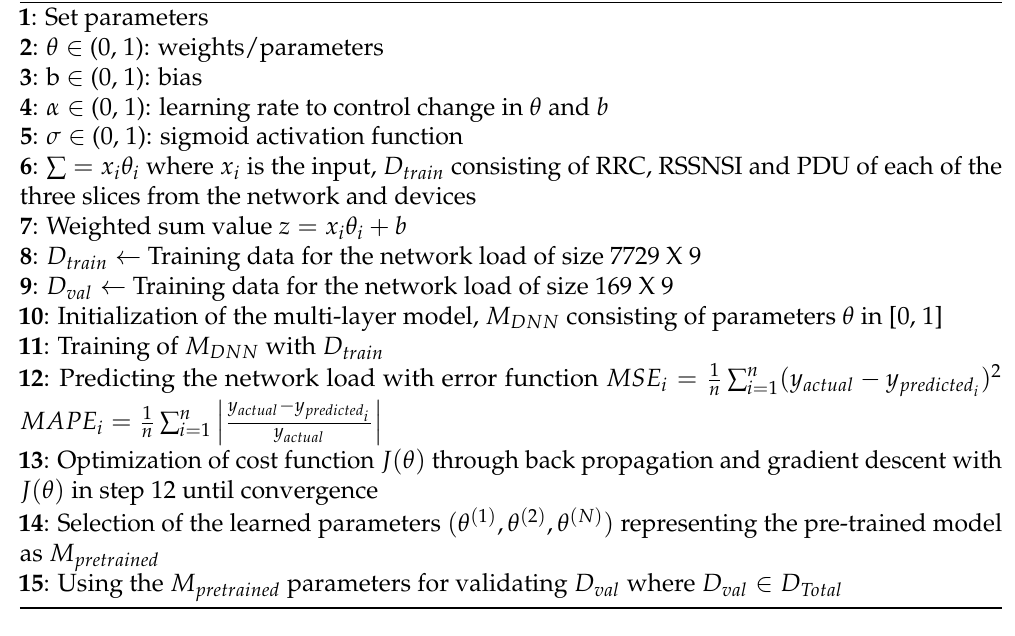
Algorithm 1 ECO6G Training and